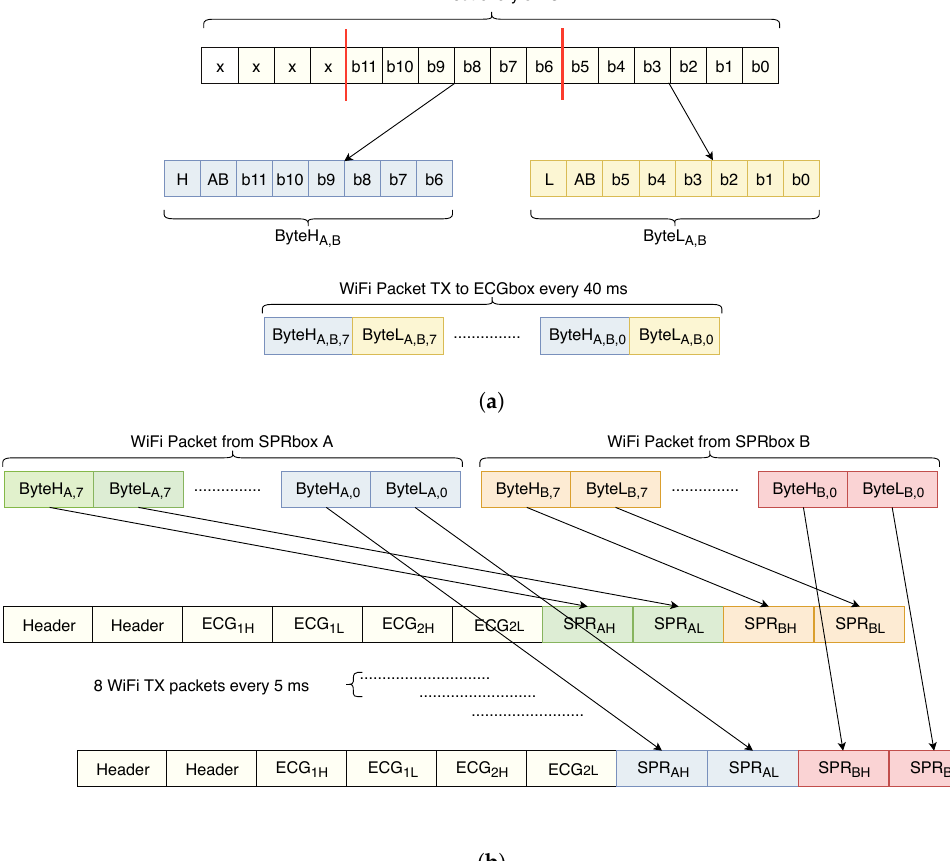
Figure 3. ( a ) Packets generation for transmission from SPR boxes to ECG box, and ( b ) packets alignment and reconstruction performed by the ECG